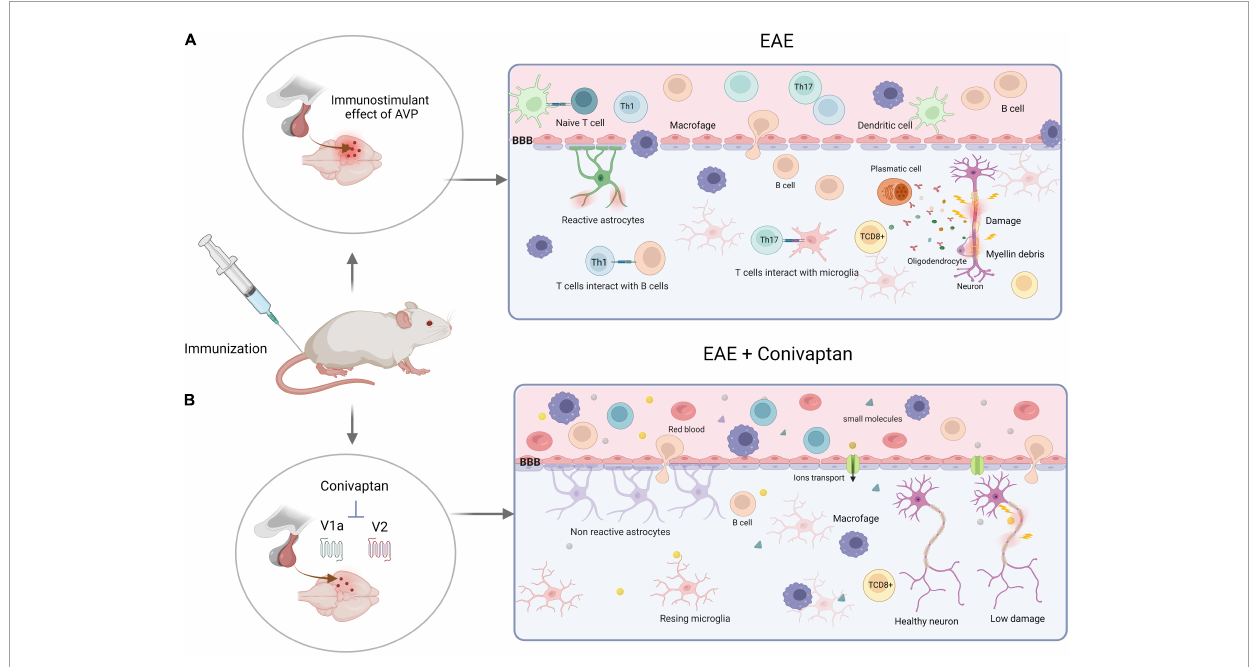
FIGURE3 Schematic illustration of experimental autoimmune encephalomyelitis (EAE) development with V1a-V2 arginine vasopressin (AVP) receptor blocker. (A) Encephalitogenic immunization of the rats trigger immune response through the activation of autoreactive T cells by dendritic cells. The clonal expansion takes place in the lymph nodes inducing cell differentiation (Th1 and Th17). At the same time, the neurohypophysial secretion of AVP affects vascular permeability of the blood-brain barrier (BBB) through the action on its receptors (V1aR and V2R), increasing the production of proinflammatory cytokines, autoantibodies and CD8+ T cells that induce axonal and myelin damage and destruction. (B) Blockade of the V1a and V2 receptors of AVP by conivaptan diminish the autoimmune, proinflammatory responses and BBB permeability. Thus, protecting the animals against developing severe EAE disease. Created with